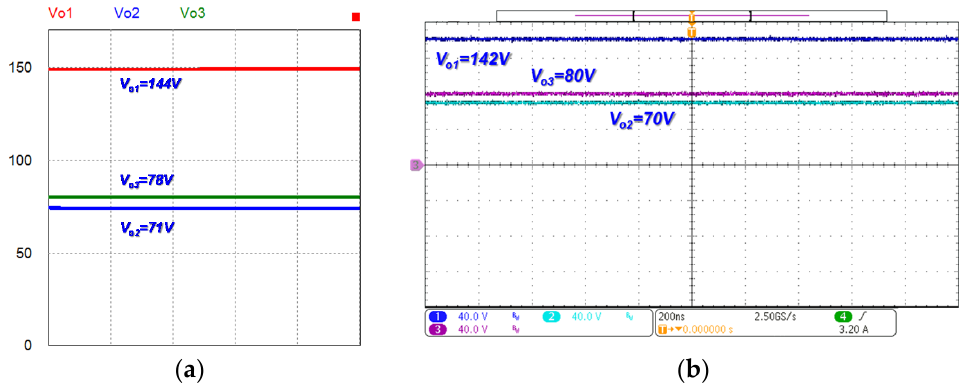
Figure 15. Output voltage waveforms in the battery charging mode: ( a ) by simulation; and ( b ) by measurement.